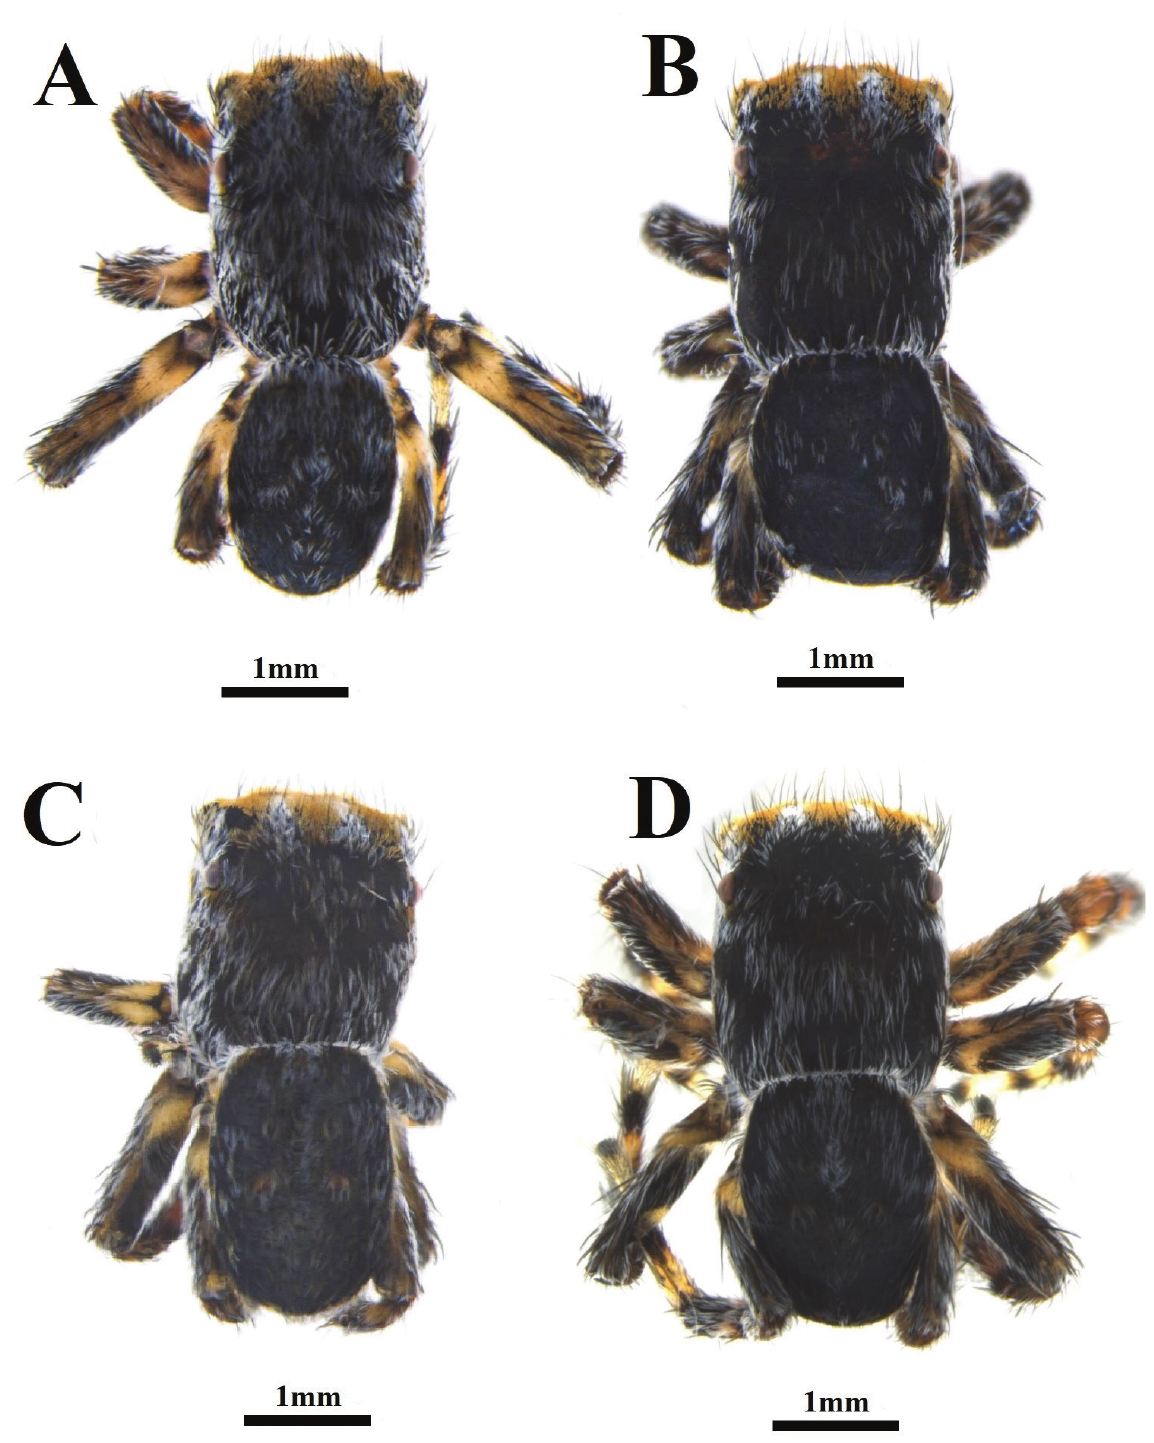
Figure 7. Variation in preserved holotype (SAM-NN30706) and paratype (paratypes: SAM NN30707‒30709) male Maratus nemo sp. nov. specimens: A paratype male (SAM NN30709) B paratype male (SAM NN30707) C paratype male (SAM NN30708) D ho- lotype male (SAM-NN30706). Scale bars: